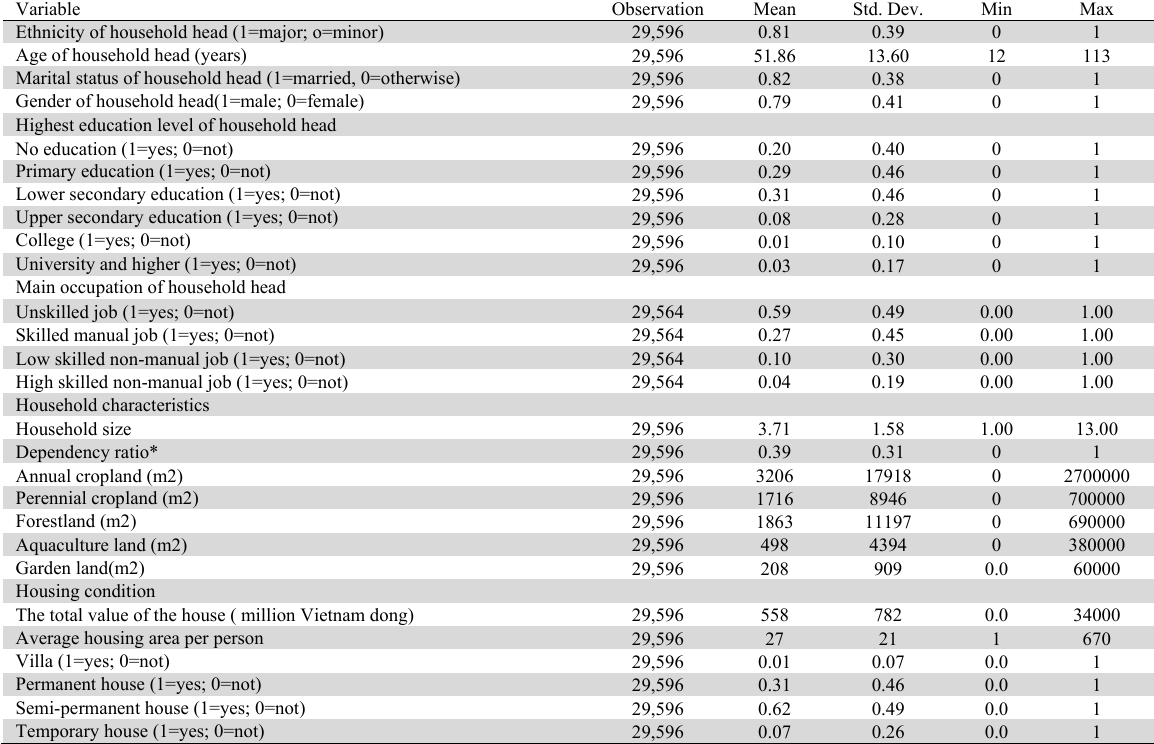
Table 1 Key characteristics of rural household sample, 2018 Variable